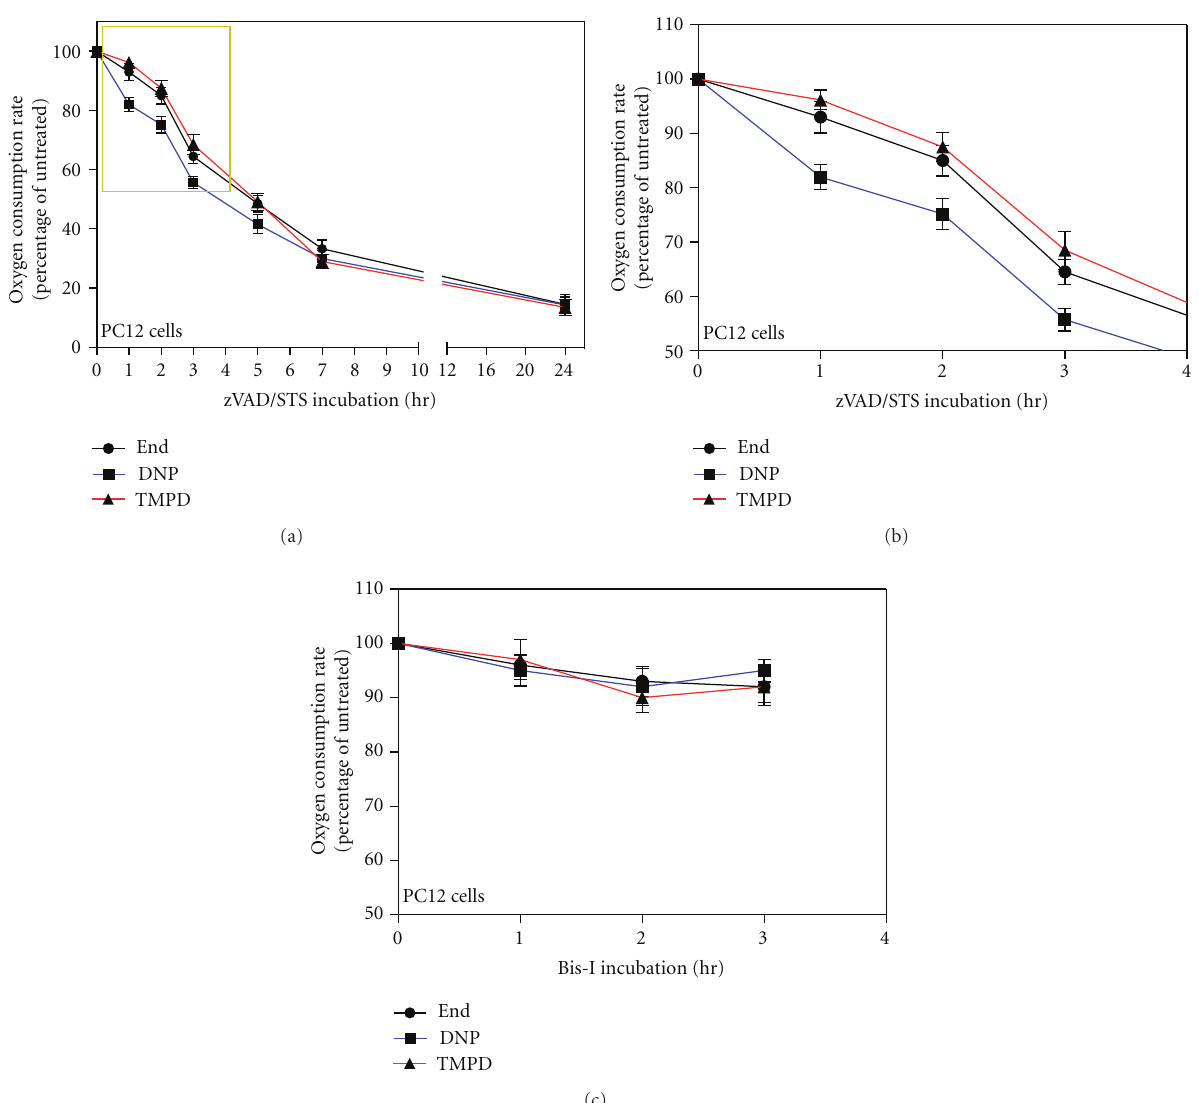
Figure 6: Decrease in endogenous, DNP-uncoupled, and TMPD-dependent respiration rates in STS-treated PC12 cells pretreated with z- VADfmk and in Bis-I-treated cells. (a) Relative oxygen consumption rates of 100 μ M zVADfmk-pretreated, 2 μ M STS-treated PC12 cells for the indicated times. Oxygen consumption rates were measured in TD bu ff er (endogenous respiration, End), in TD bu ff er containing DNP (DNP-uncoupled respiration, DNP) and in TD bu ff er containing DNP, antimycin A, ascorbate and TMPD (TMPD-dependent respiration, TMPD). Data are expressed, at each time point, as percentages of the oxygen consumption of untreated cells (0hr). Data are expressed as means ± SE with n varying at each time point and being 8, 6, 6, 2, 3, 2, 3 for 1h, 2 h, 3h, 5 h, 9h, and 24h, respectively. (b) Magnification of the panel (a) area surrounded by a yellow frame. Note that the ordinate scale starts at 50%. (c) Relative oxygen consumption rates of Bis-I-treated PC12 cells for the indicated times. Data are expressed as means ± SE with n varying at each time point and being 5, 6, and 5 for 1h, 2h, and 3h